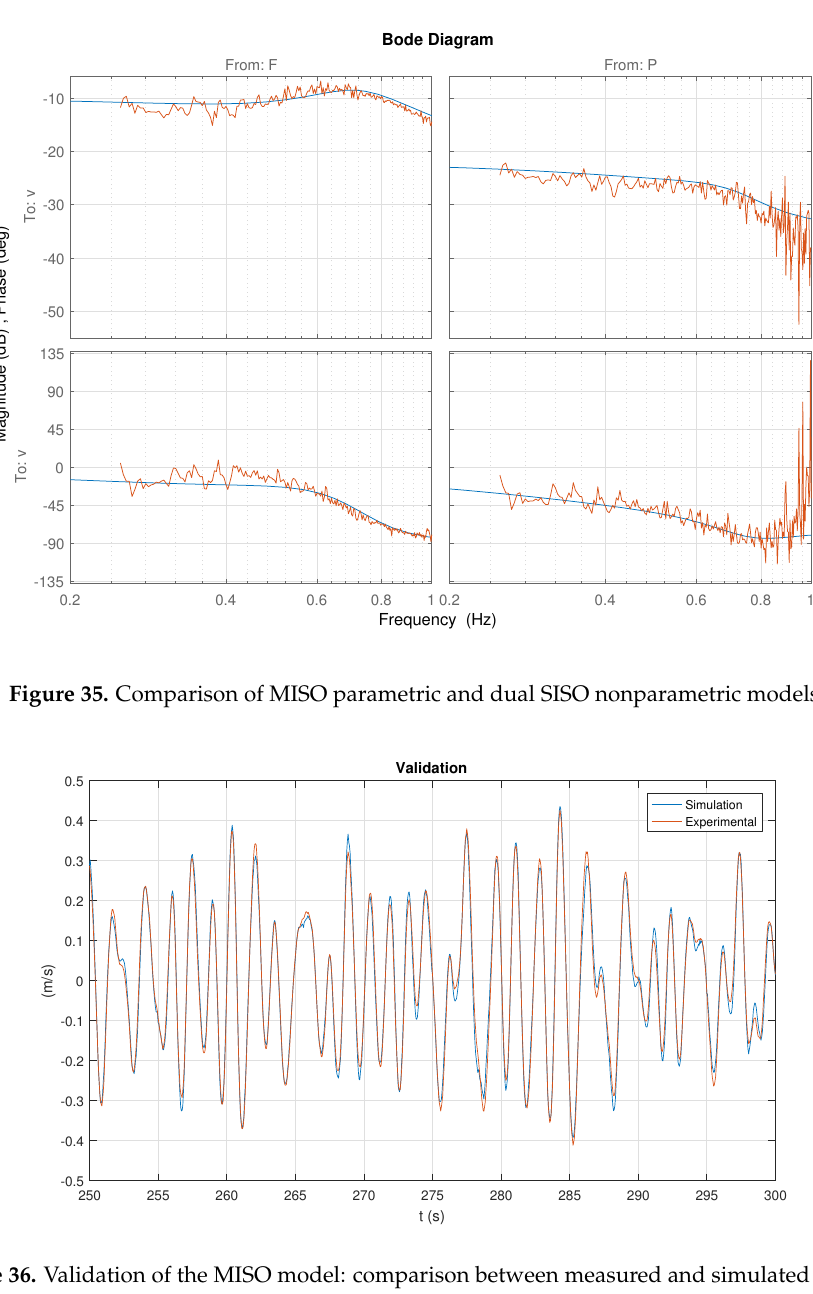
Figure 36. Validation of the MISO model: comparison between measured and simulated